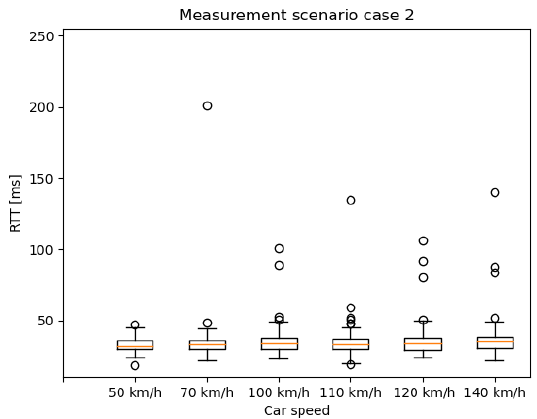
Figure 11. RTT results with different car speeds—scenario 2: from 10 ms IAT and 250 Byte PL, to 310 ms IAT and 4000 Byte PL, increment the PL by 250 Byte for every iteration and the IAT by 100 ms for every fourth iteration.